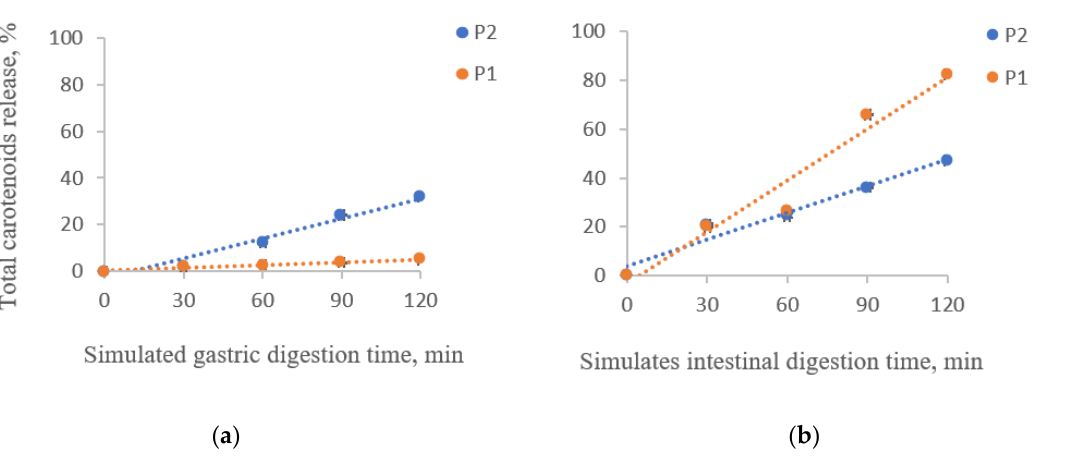
Figure 2. Total carotenoids release from the powders during the in vitro simulated gastric ( a ) and intestinal digestion ( b ). P1 = powder with 2% WPI and 2% CMC; P2 = powder with 4% alginate, 1% agar, and 4% chitosan.